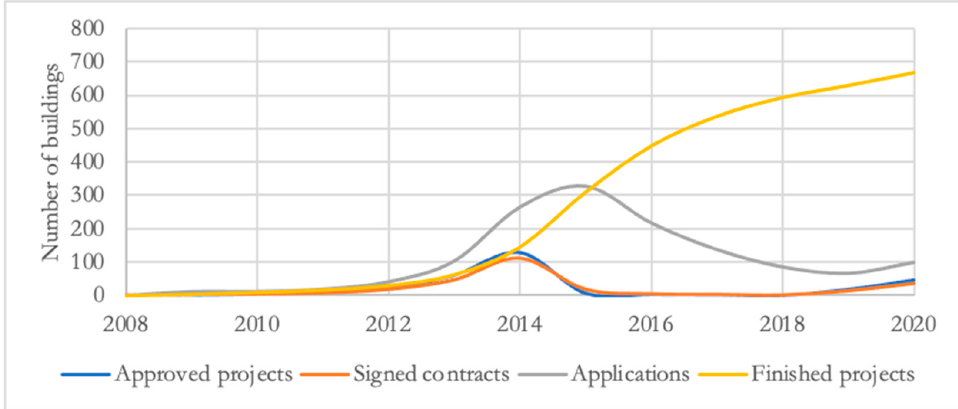
Figure 18. Simulated number of renovated buildings when actual policy tools are applied.